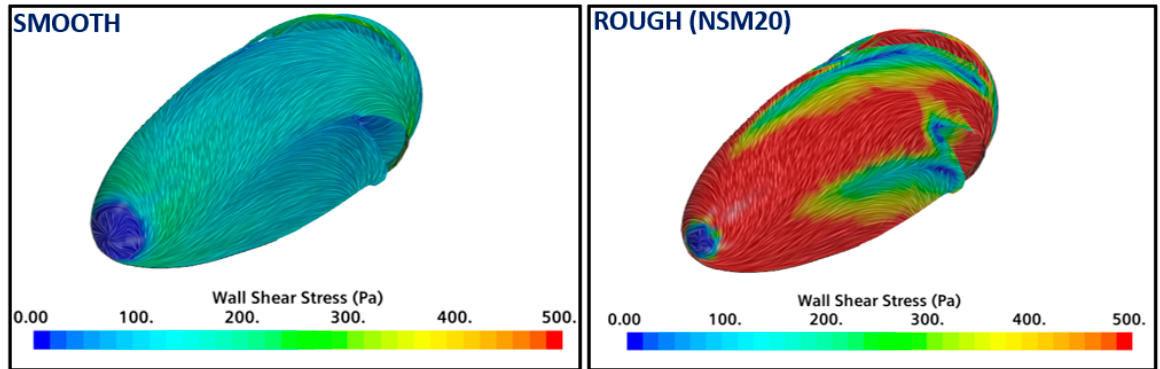
Figure 8. Comparison of wall shear stresses between smooth and rough conditions.